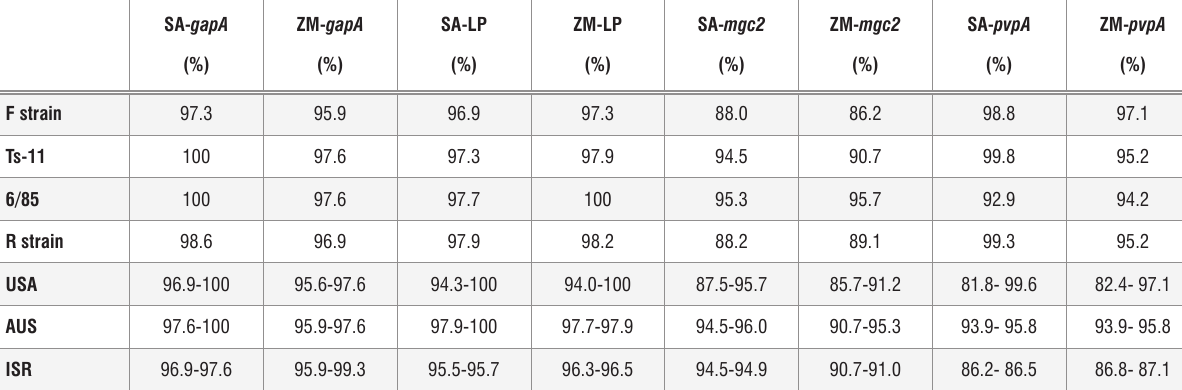
Table 2: Similarity (percentage identity) of South African and Zimbabwean sequences in comparison with vaccine and reference genotypes and genotypes from other countries